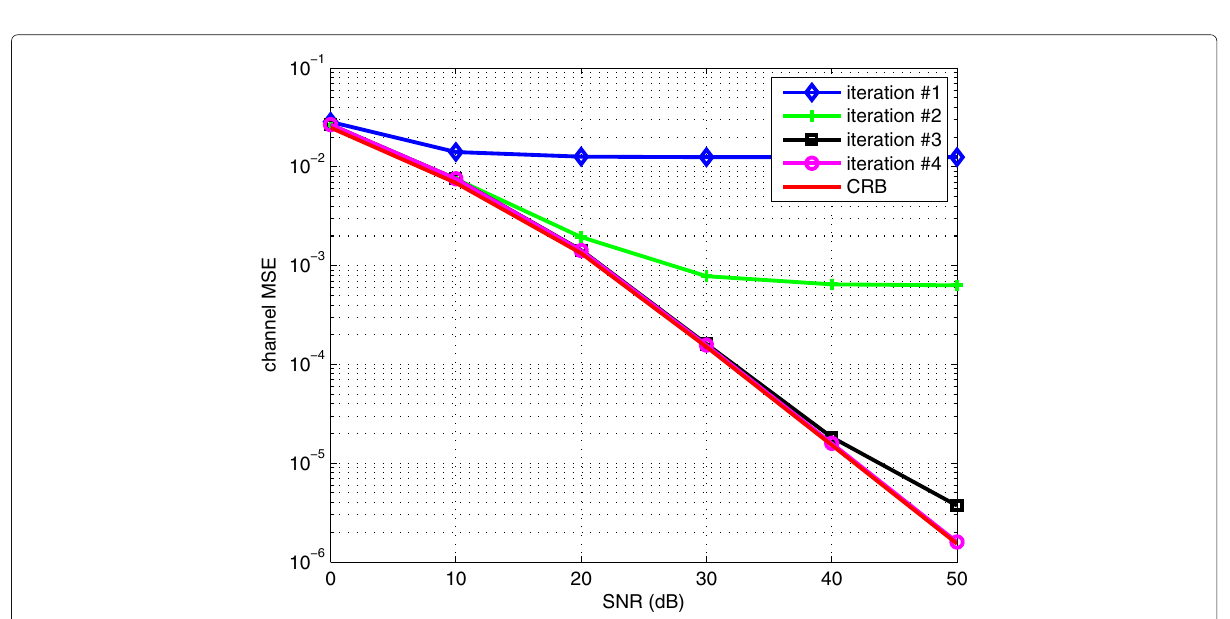
Fig. 6 Performance of the CML estimator as a function of the SNR for SIR = − 5 dB, K =